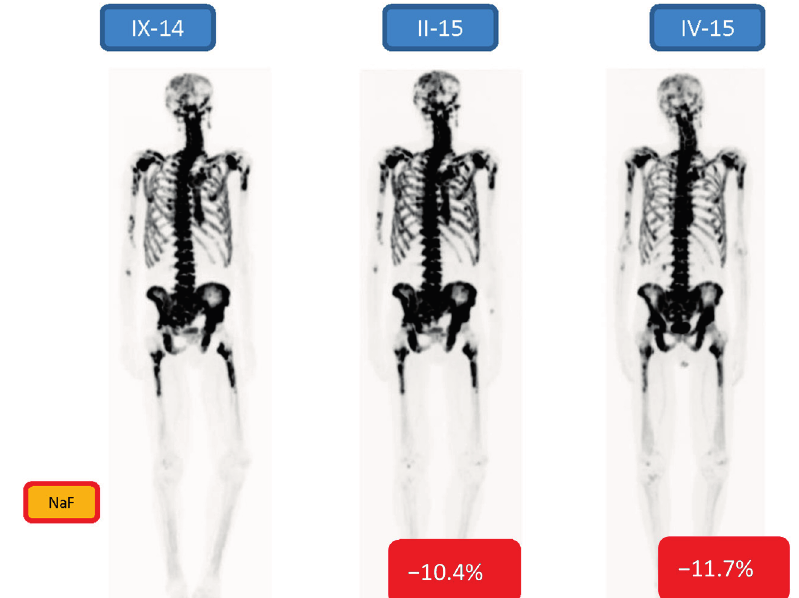
Figure 2. 69-year old male, Gleason score 8 (diagnosed in 2012), treated earlier with Casodex, Zoladex, S-PSA 671 ng/mL at initial visit in (VII/14), was treated with 6 cycles of 223 RaCl 2 . A NaF-PET-CT study before (IX-14), one interim study (after two cycles, II-15) and one study (IV-15) after the 6 six cycles are shown. There is a quantitative response ( − 10.4% and − 11.7%) in both the interim and post therapy NaF-PET-maximum intensity projection